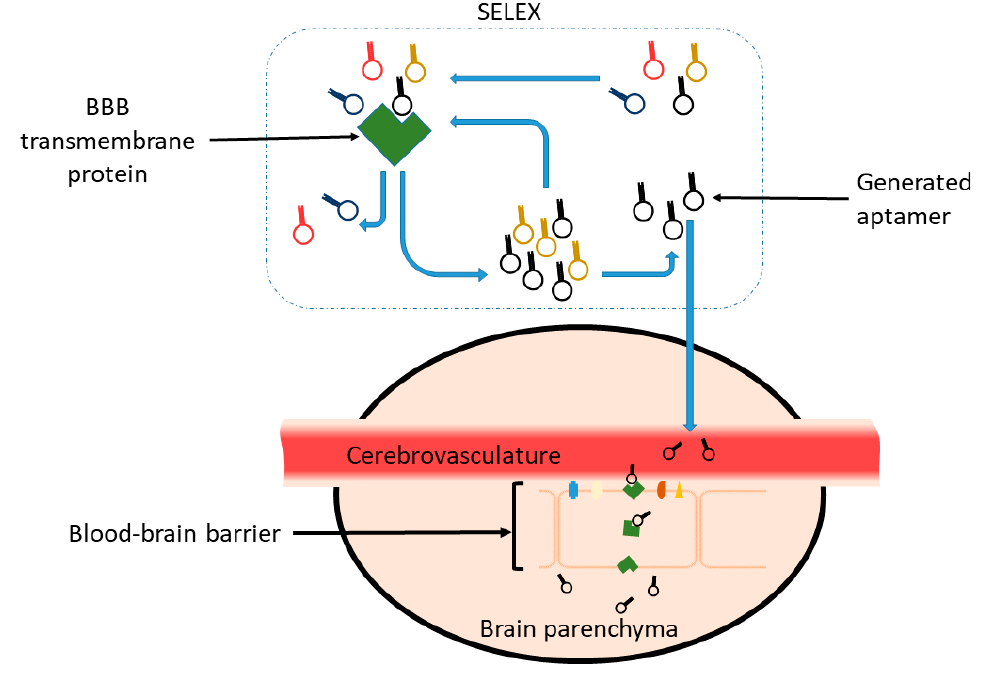
Figure 2. Aptamers generated against transmembrane proteins that are involved in transport mechanisms on the BBB could potentially overcome the restrictive nature of the barrier and make their way into the brain environment. Blue arrows show the chronological steps involved generating aptamers in protein SELEX. Figures adapted from references